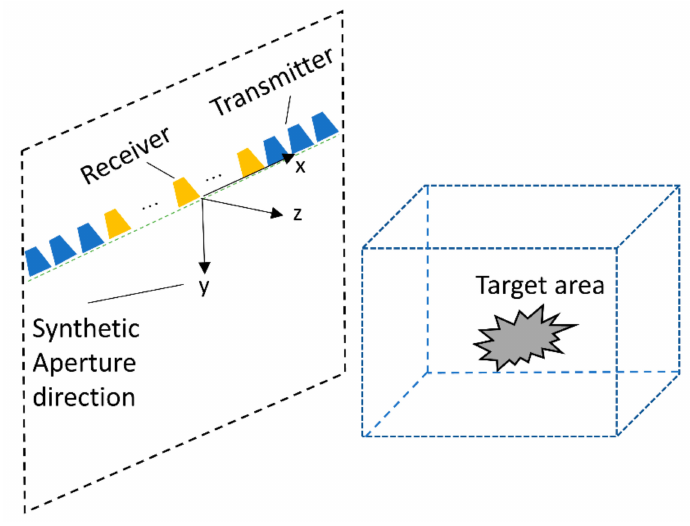
Figure 1. The scheme of the MIMO-SAR